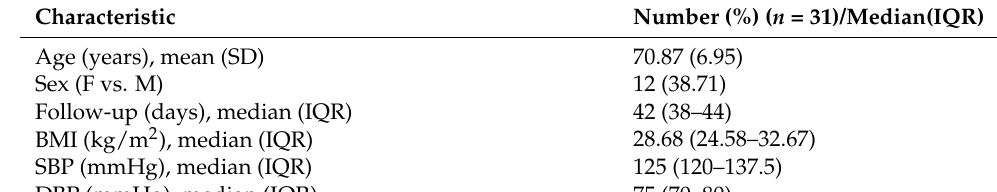
Table 1. Baseline